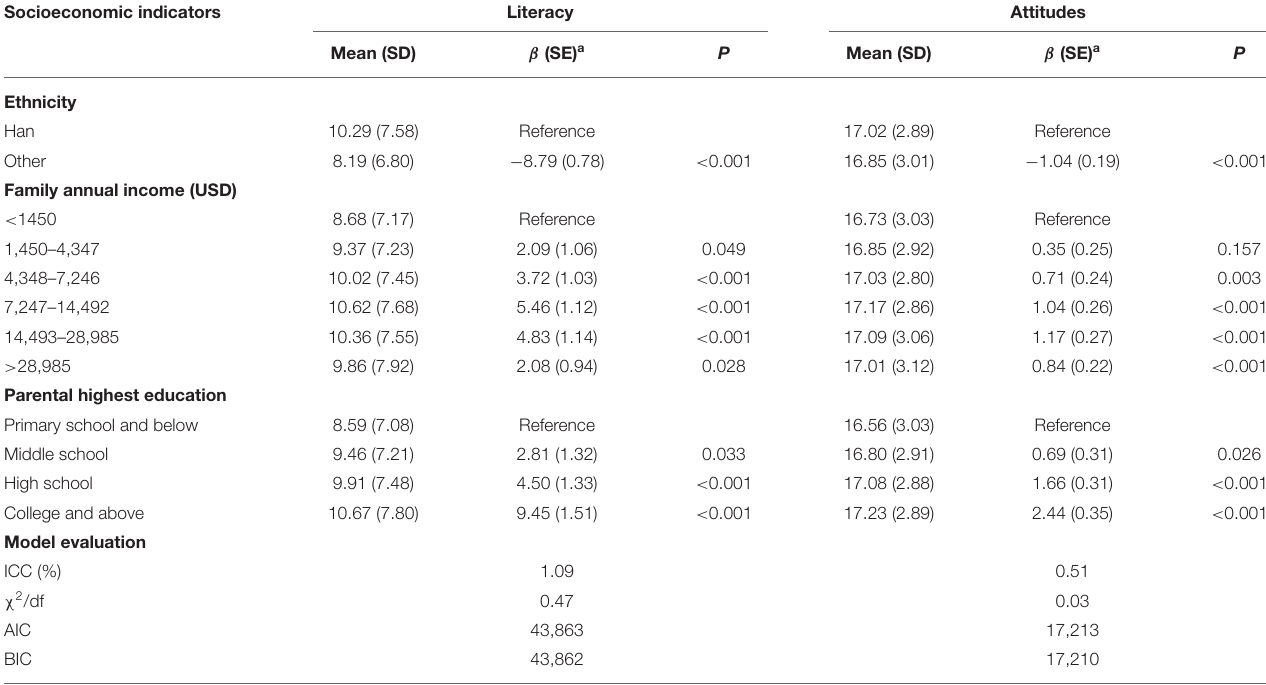
TABLE 2 | Associations of parental socioeconomic status with melanoma-related literacy and attitudes estimated using two-level log-Gamma models. Socioeconomic indicators Literacy